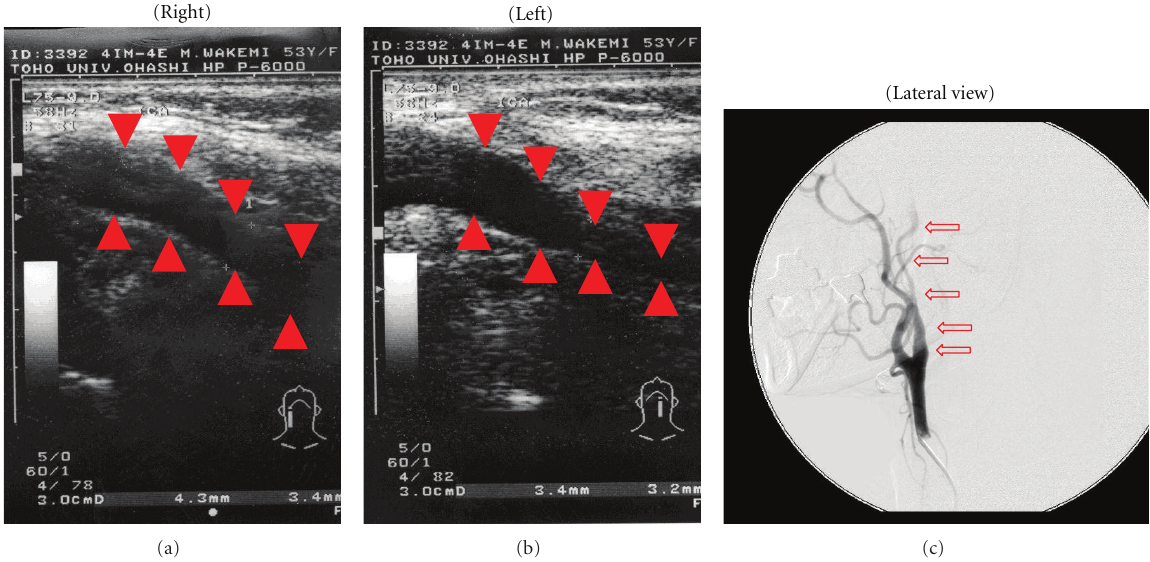
Figure 2: Preoperative cervical echograms (a, b) and left cervical angiogram (c). The lumen of the internal carotid artery (ICA) in echograms is indicated by arrowheads, and the left ICA in angiogram is indicated by arrows. The left cervical common carotid artery (CCA)-ICA echogram indicated severe stenosis towards the distal end of the left ICA without wall thickening (interna-media thickness = 0.8) (b) compared with the right CCA-ICA echogram (a). The lateral view of the left cervical angiography also indicated stenosis and winding of left ICA towards the distal intracranial region